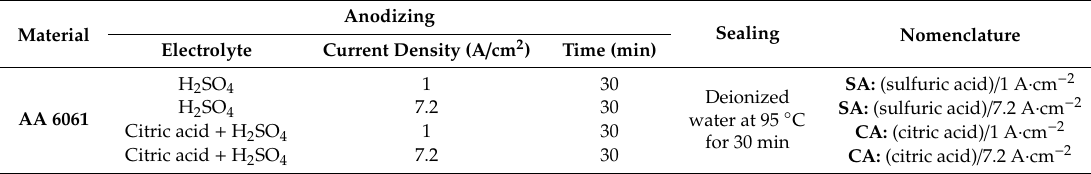
Table 1. Process parameters for anodizing and nomenclature of the anodized